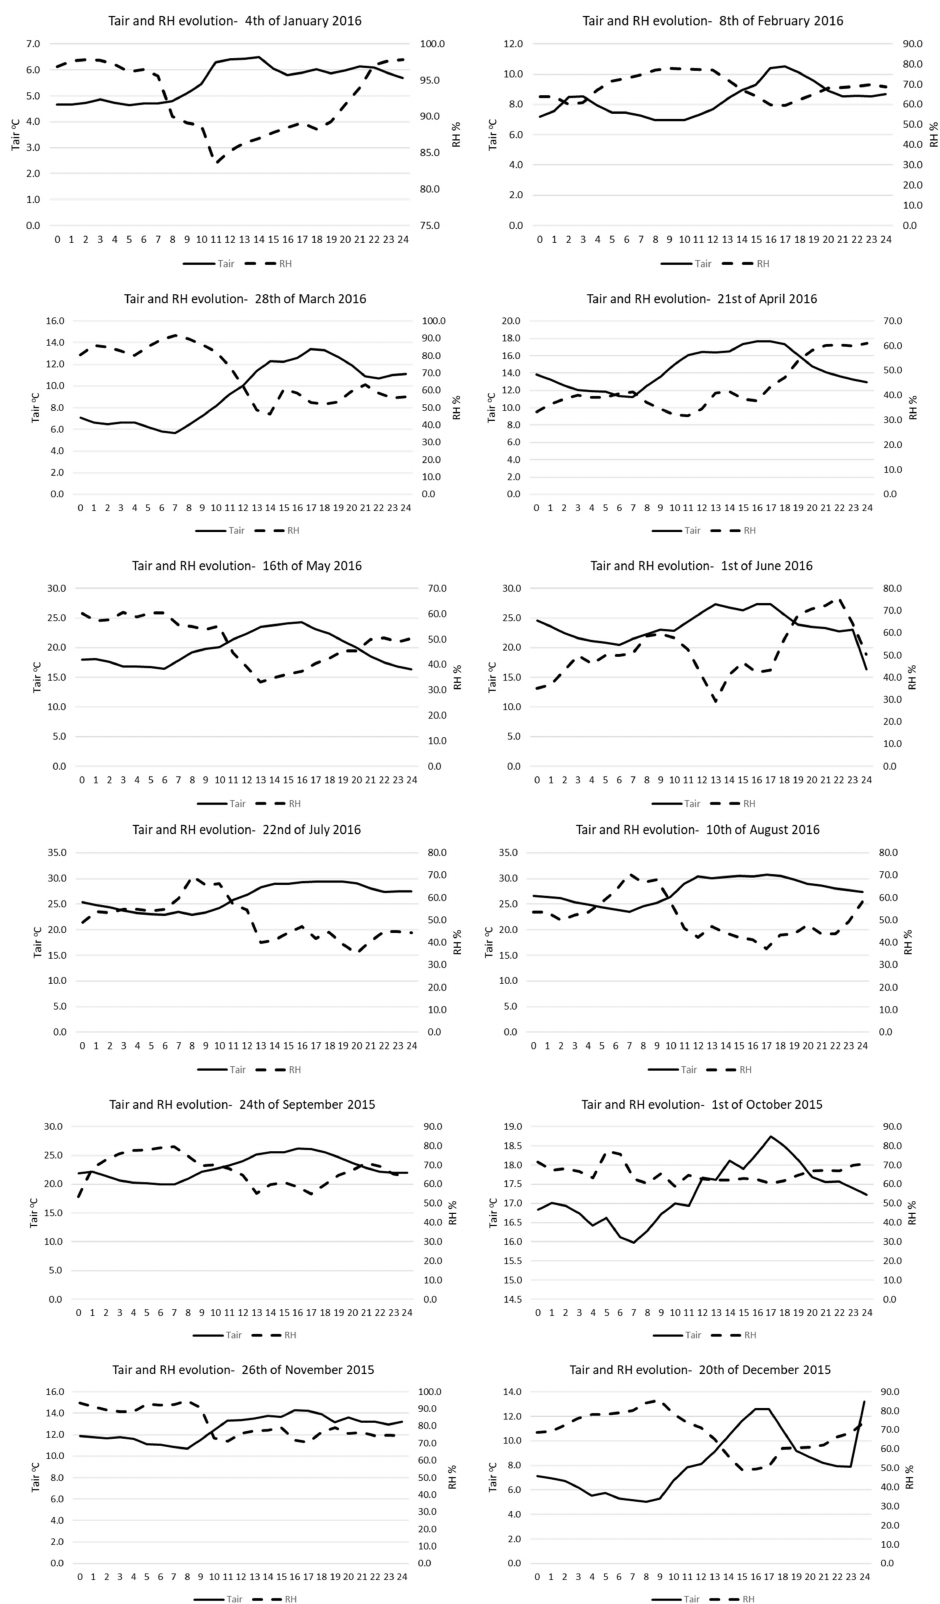
Figure A1. Hourly Tair and RH values as input boundary conditions for microclimate simulations of the 12 representative